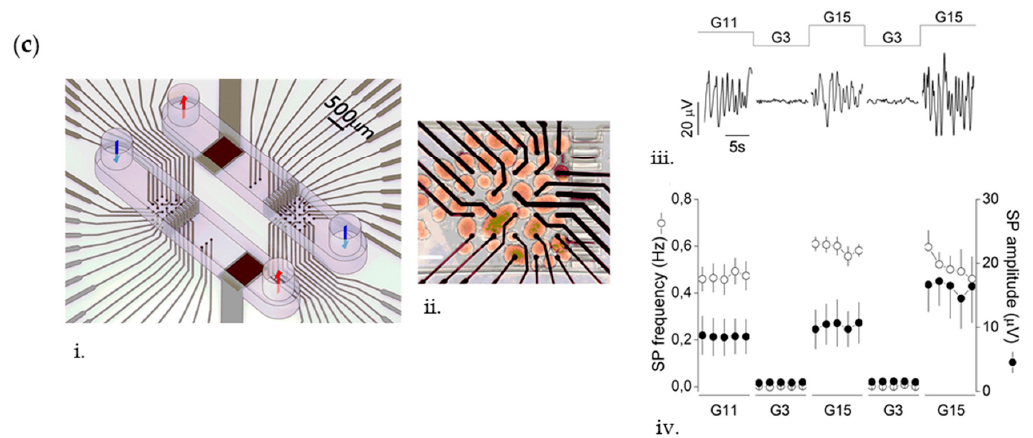
Figure 5. ( a ) Design of the microMEA platform: scheme showing the microfluidic and microelectrode components of the platform (i) and exploded view showing the di ff erent lithography layers for the fabrication of the multielectrode array (MEA) (ii). The light transmission and fluorescence images of the device (iii) show the positions of axonal, reference, and postsynaptic electrodes, and a reconstructed cortico-cortical network with GFP (Green Fluorescent Protein)-expressing axons and mCherry-expressing postsynaptic dendrites at DIV 10. Monitoring postsynaptic calcium dynamics via high-resolution microscopy in response to presynaptic electrical activity of a single projecting axon (iv) show that weak postsynaptic calcium signals are related to projecting axons with low-frequency activity, whereas larger calcium signals are related to projecting axons with high-frequency activity. Insets show magnification of boxed areas. Adapted from Ref. [136] with permission from The Royal Society of Chemistry. ( b ) Design of the three-nodal microfluidic chip (i) and tiled brightfield images of all cell compartments (ii), with a magnification showing a zone between two nodes. Design of MEA layout aligned with the 3-nodal chip design and magnified image of internodal area (iii). The functional map of the connectivity (correlation of concurrent spikes) between electrodes in the 3 nodes at DIV 18 show high degree of internodal connectivity (iv, green: top node, purple: bottom node, and orange: middle node). Adapted from Ref. [53] with permission from Elsevier. ( c ) Scheme of microfluidic MEAs for the analysis of pancreatic islets (i), showing two symmetric chambers. Each chamber has two compartments separated by microchannels, 1 with 26 recording electrodes and 1 with 3 control electrodes and 1 reference electrode. Microscopic image of intact islets 4 days after seeding in the microfluidic MEA chamber shows good electrode coverage (ii, scale bar 200 µ m). Representative recording of islets’ slow potentials (iii) obtained 2h after seeding on microfluidics MEAs under di ff erent glucose concentrations (RPMI medium (Roswell Park Memorial Institute) containing 11mM glucose or bu ff er containing either 3 or 15mM glucose) show islets glucose-dependent electrical activity. Frequency and amplitude analysis of slow potentials are also reported (iv), considering the last 5 min of each condition (lasting 10min) and providing mean data for each minute. Adapted from Ref. [153] with permission from